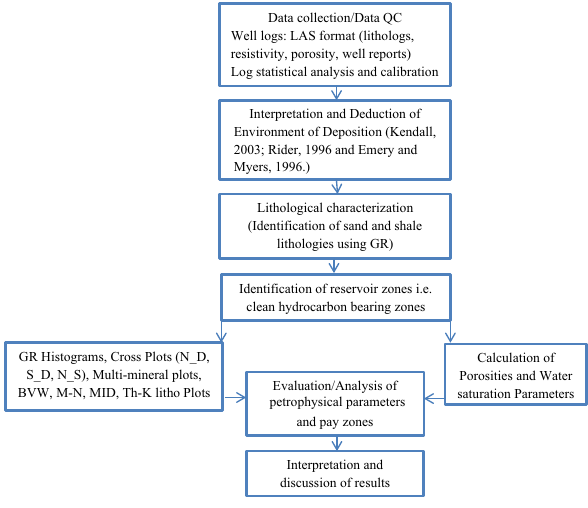
Fig. 3 Workflow adopted to characterize reservoirs, offshore SE Douala Basin,